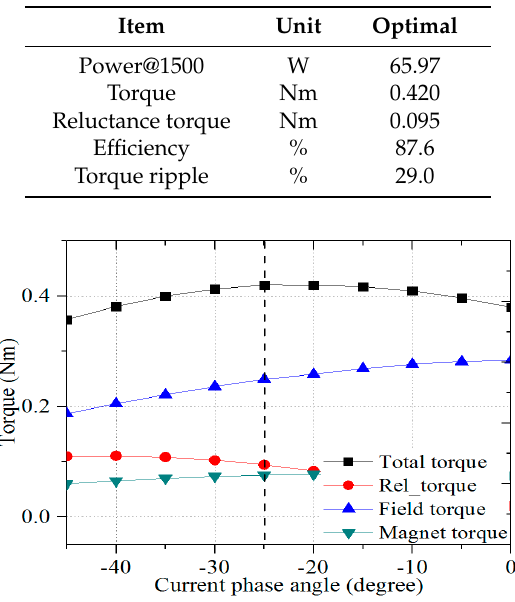
Figure 12. The torque characteristics of optimal model.